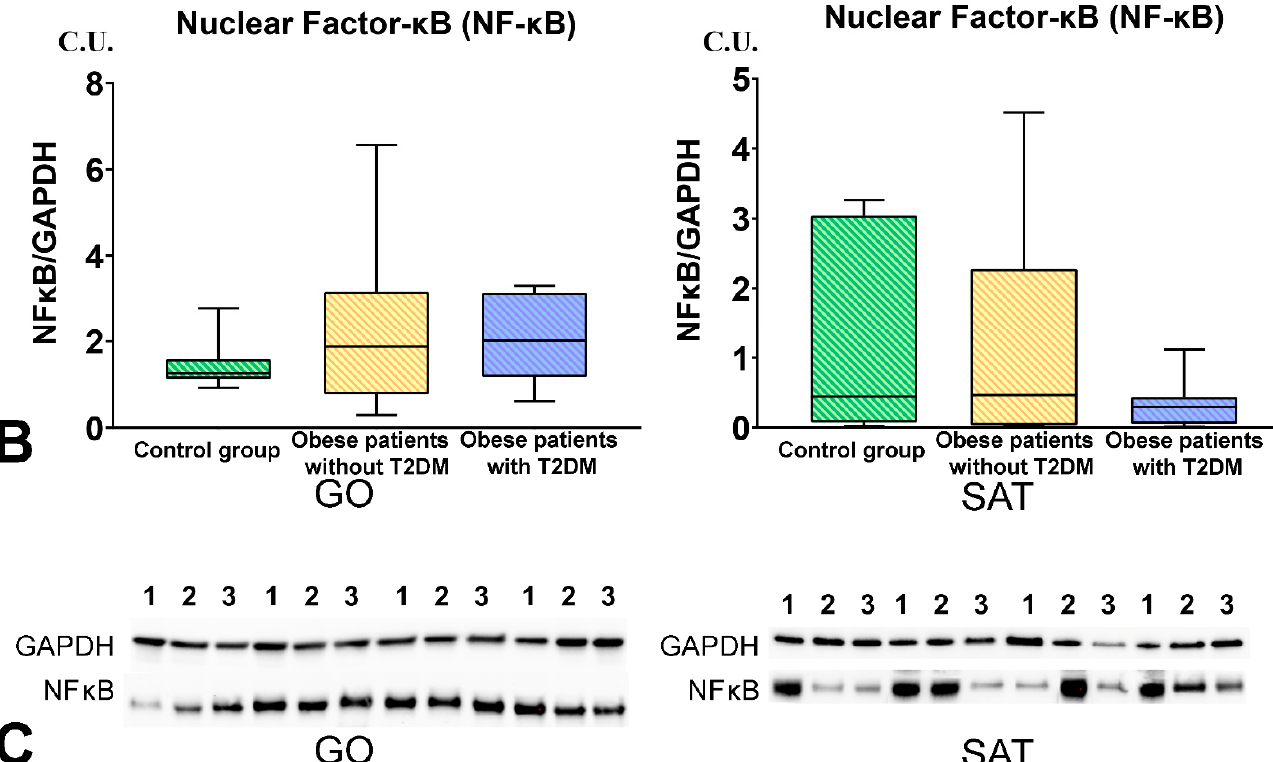
Figure 5. Study of NF-kB tissue-specific production in obese patients with and without T2DM. ( A )— NF-kB1 gene expression in GO and SAT, n = 25; ( B )—NF-kB (p65) protein production in GO and SAT, Western blot analysis of AT biopsies, n = 8; ( C )—Protein NF-kB (p65) Western blot bands, n = 8. *— p < 0.05 significance is determined using the Mann–Whitney criterion for two independent samples.